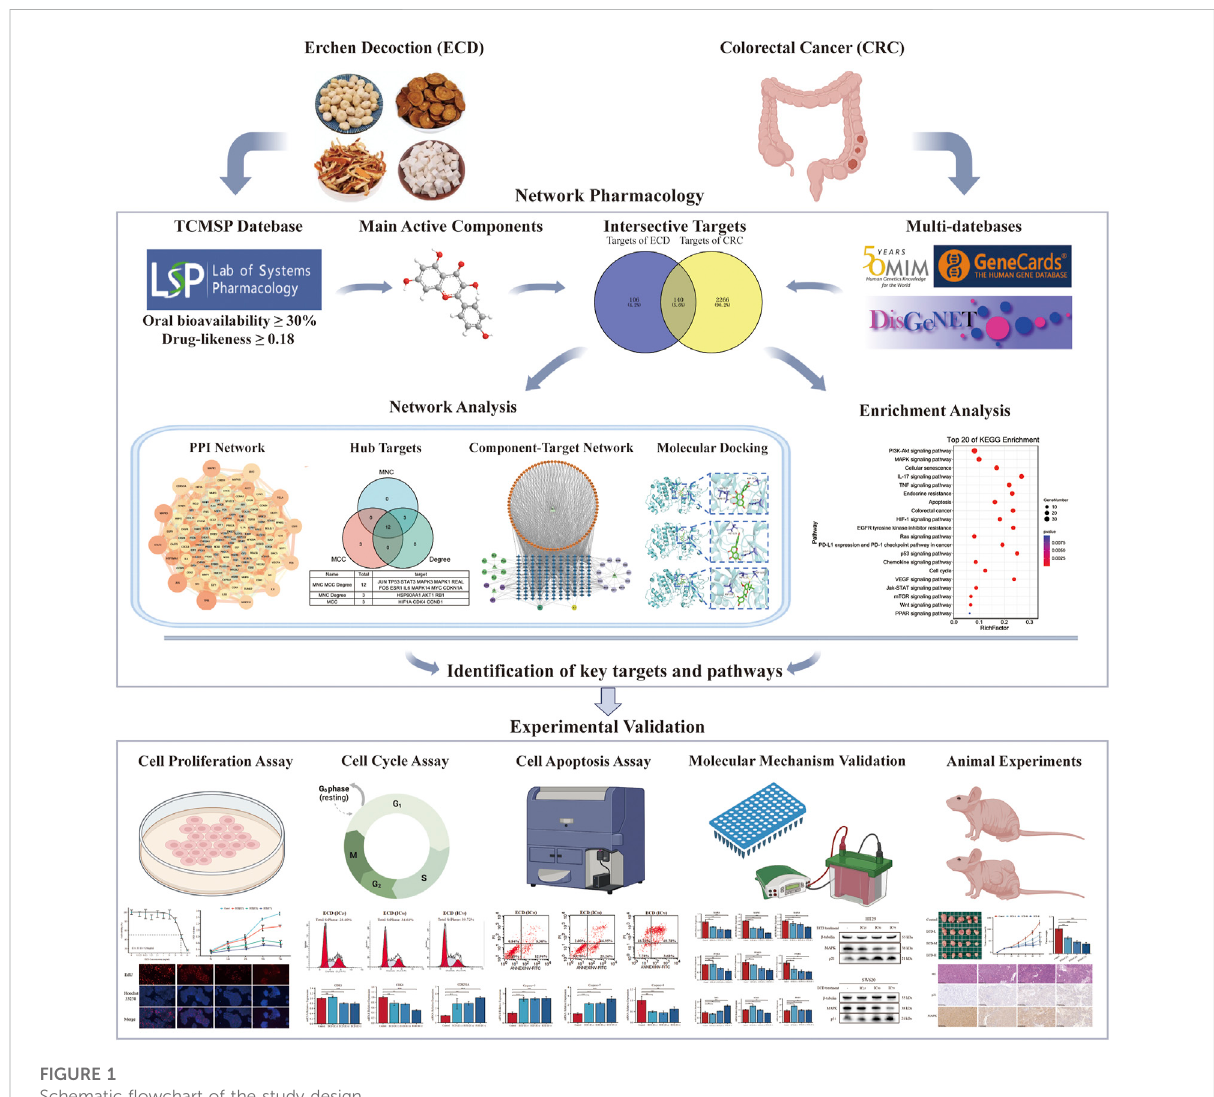
FIGURE 1 Schematic fl owchart of the study design.